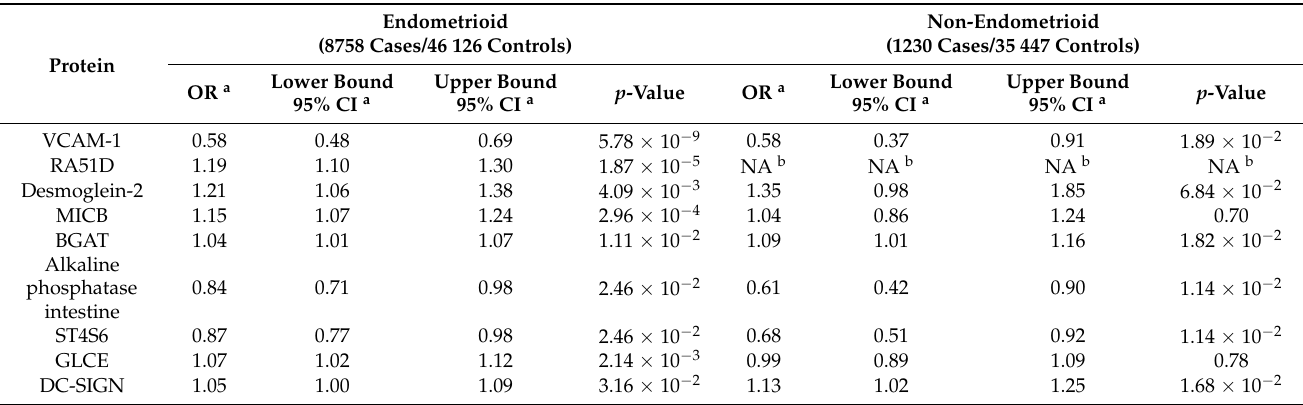
Table 2. Associations between genetically predicted protein concentrations and endometrial cancer risk by subtypes of endometrial cancer (endometrioid and non-endometrioid).